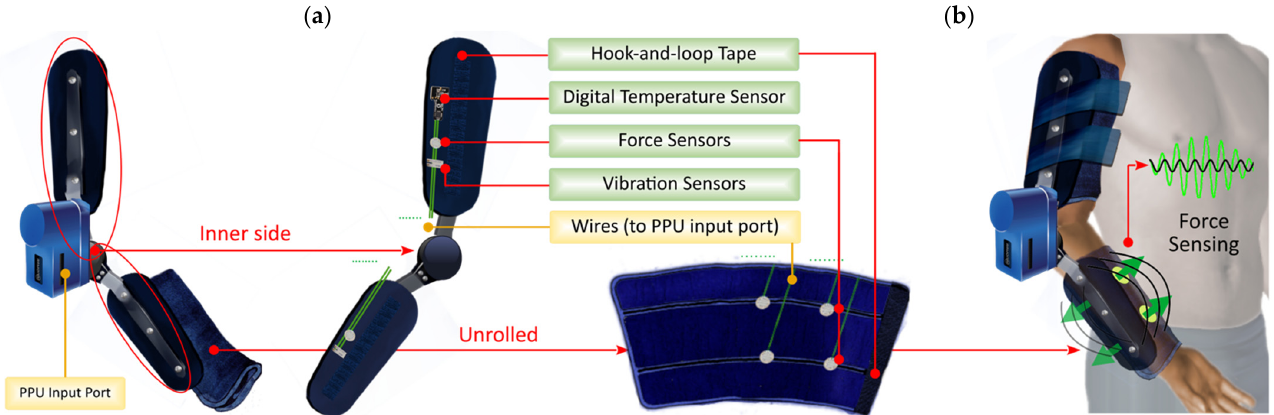
Figure 5. Peripheral sensors integrated into the exoskeleton. Part ( a ) shows the location of the sensors on the structure. Part ( b ) shows the force sensors that detect variations in the forearm when flexion or extension occurs.